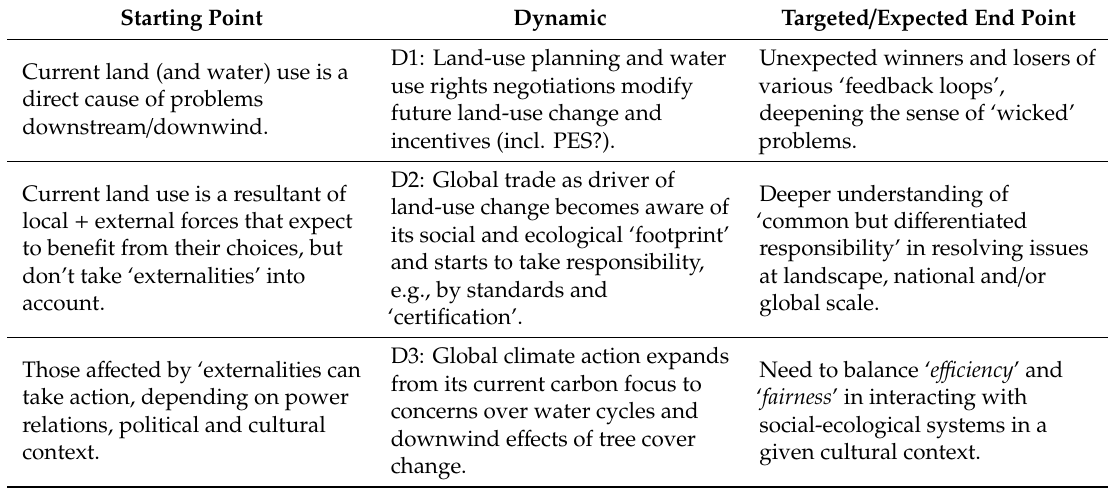
Table 7. Prototype of a ‘closing-the-loop’ game, with targeted / expected endpoints as hypothesis for further corroboration; type D in Figure 10.